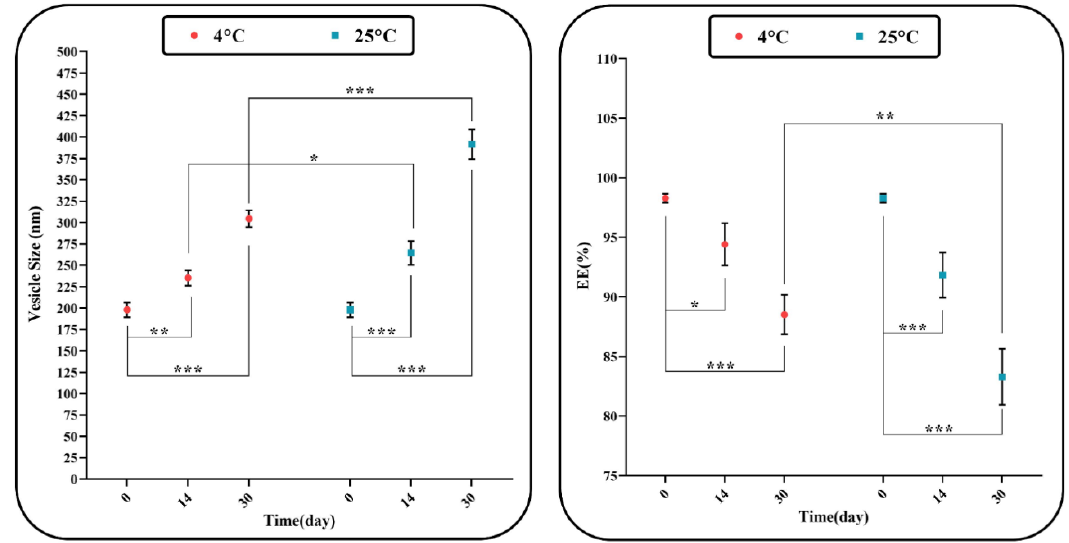
Figure 7. Stability of optimum AL-NioC over one month of storage at 4 ± 2 °C and 25 ± 2 °C, (* p -value < 0.05, ** p -value < 0.01, and *** p -value < 0.001).